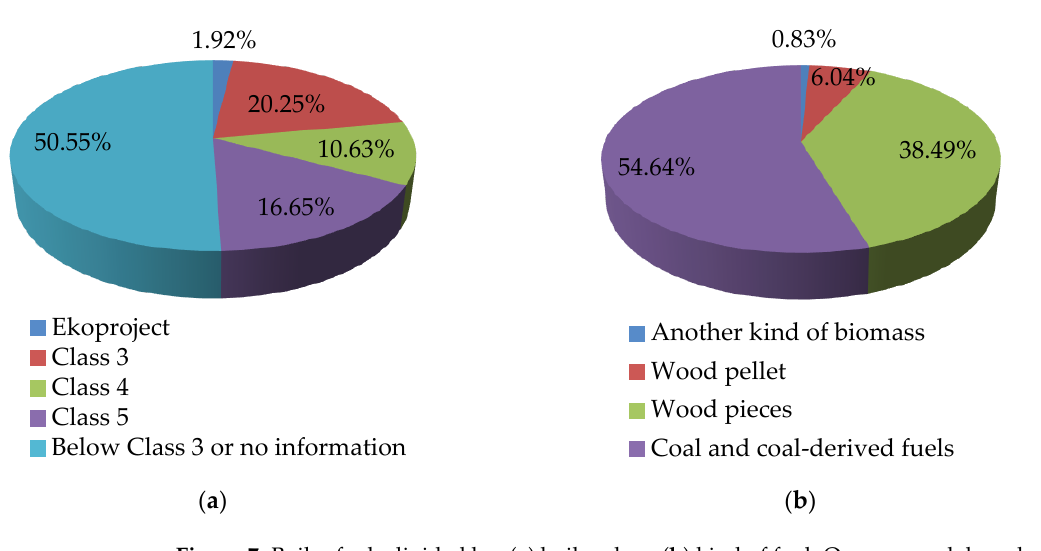
Figure 8. Sources of heat used in residential buildings. Own research based on [60].